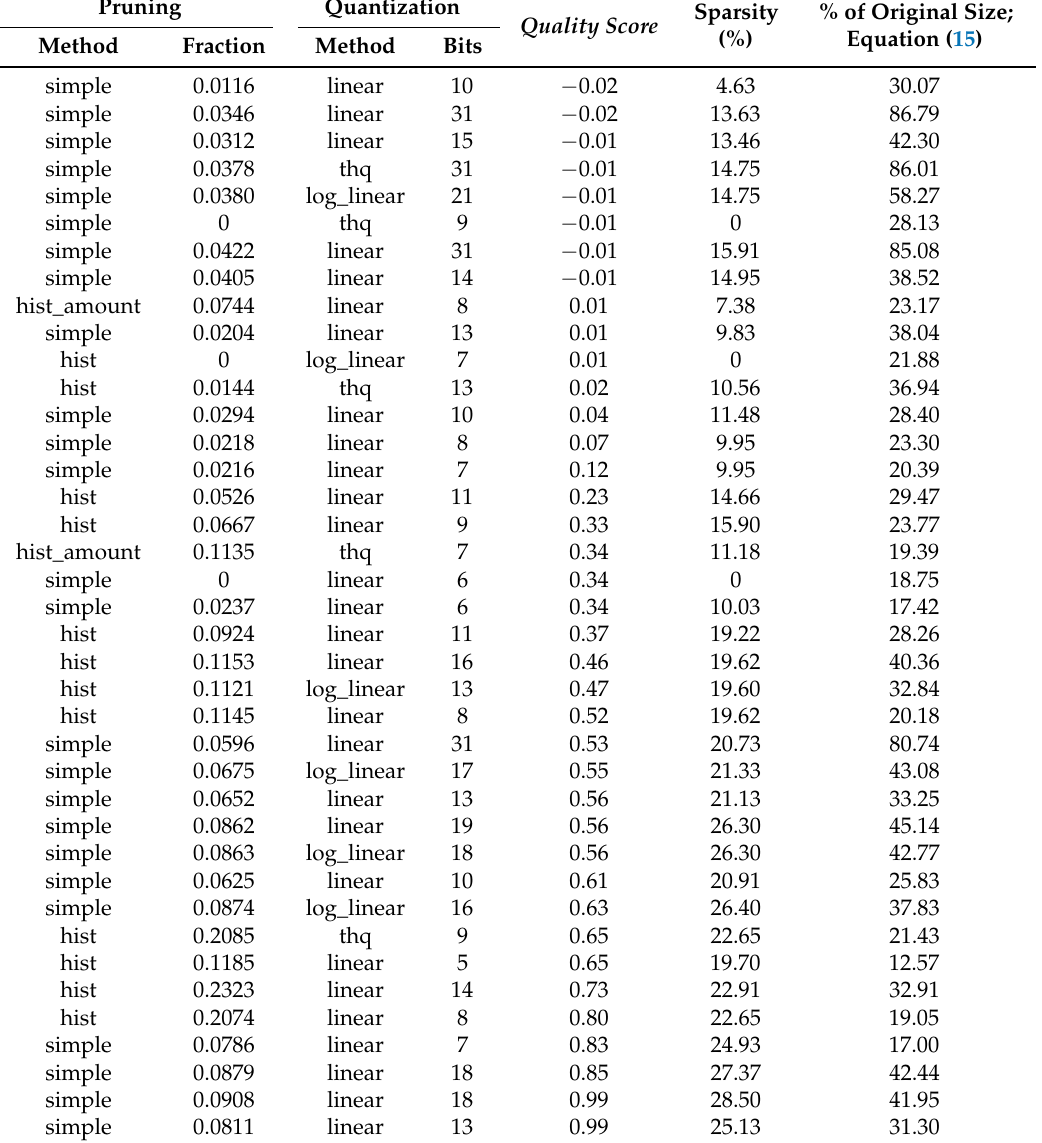
Table A4. [PM2.5] Results for pruned and quantized